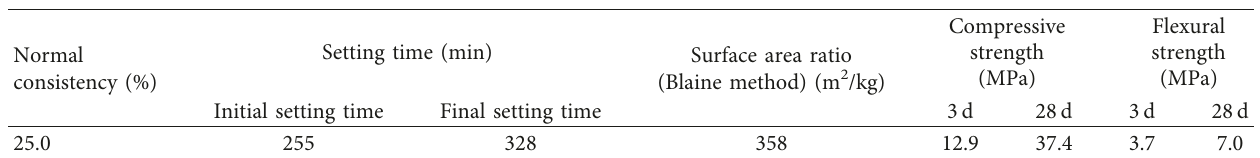
Table 4: Experimental results of cement.